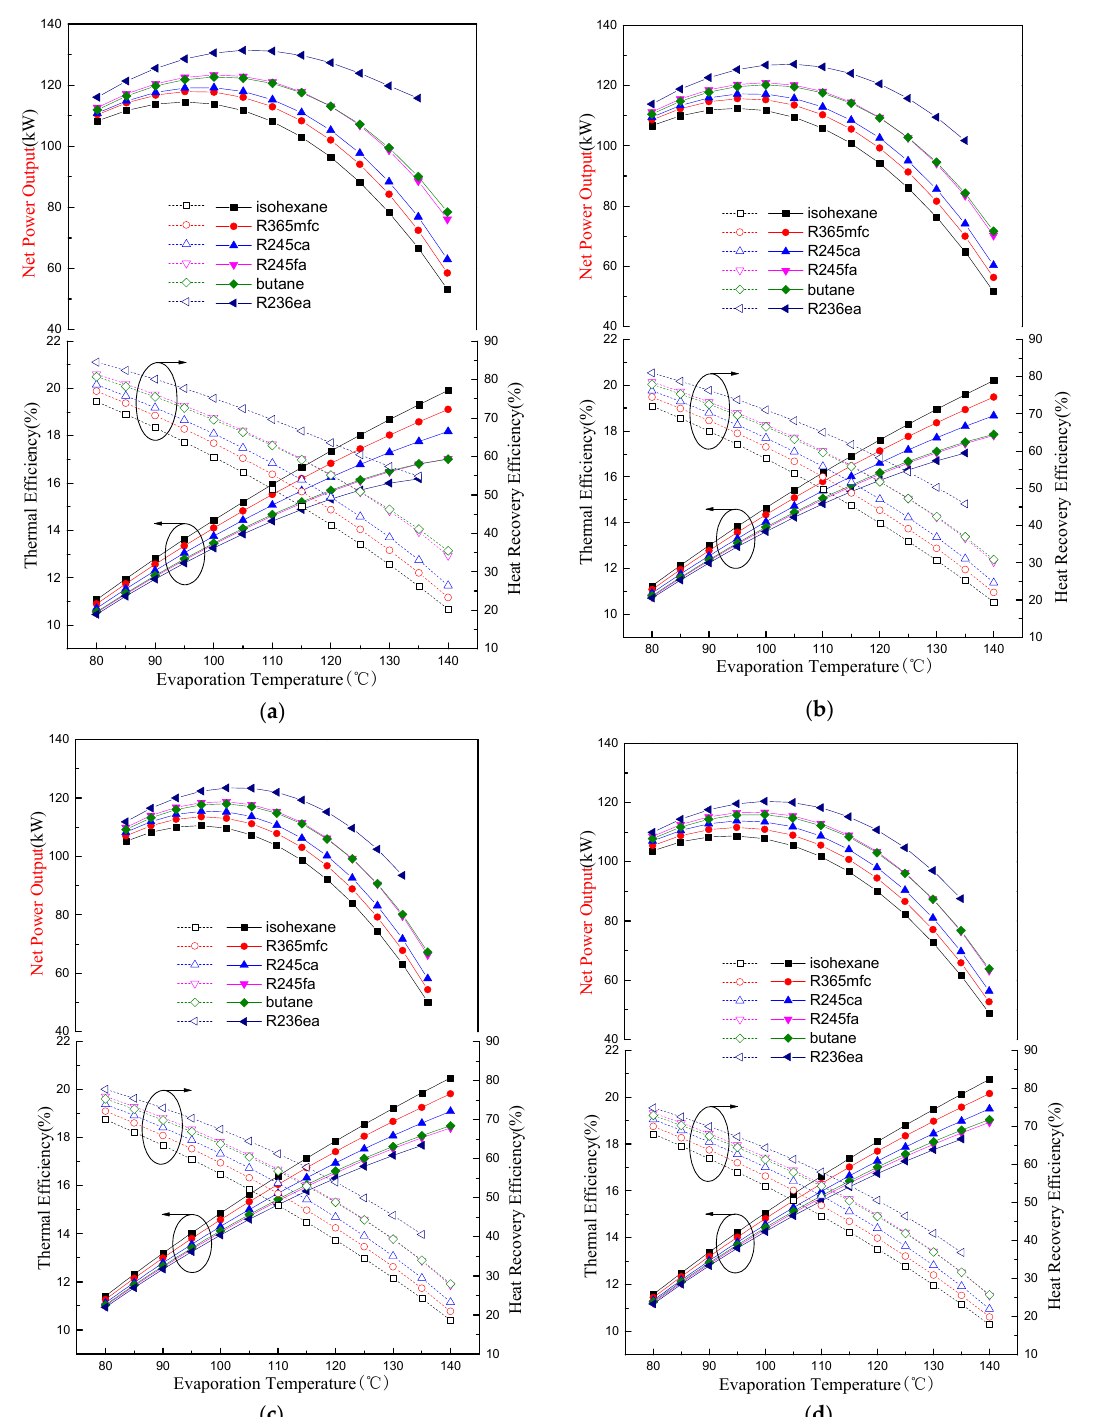
Figure 4. Variations of net power output, thermal efficiency, and heat recovery efficiency with evaporation temperature at four different degrees of superheat: ( a ) 0 °C degree of superheat; ( b ) 5 °C degree of superheat; ( c ) 10 °C of superheat; and ( d ) 15 °C degree of superheat.